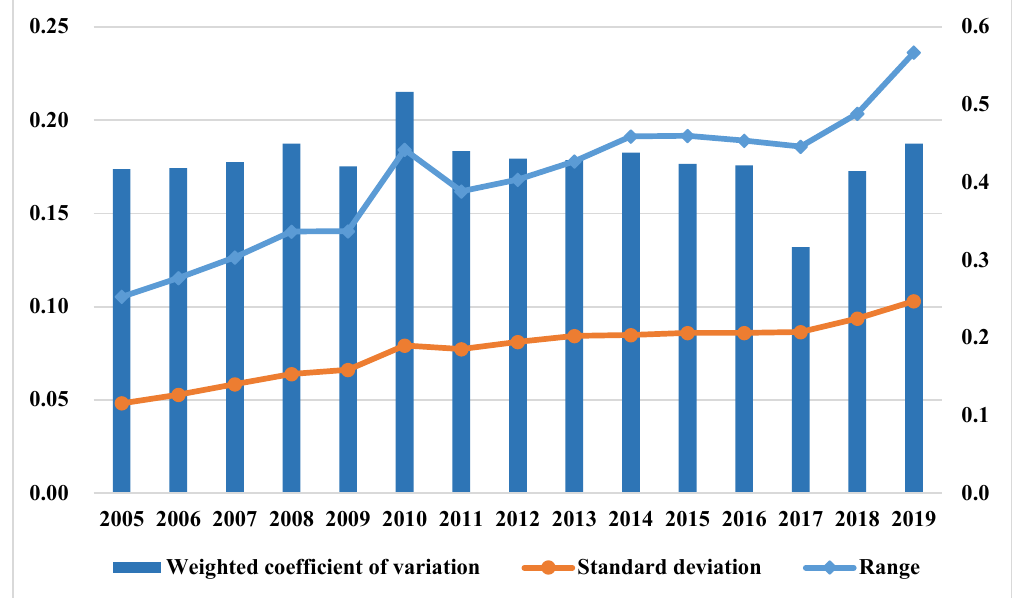
Figure 3. The absolute and relative differences of development level of open economy in the YRDA. From the point of view of evaluating the four subsystems of the development level of the open economy, the foundation of open economy in the YRDA shows a trend of steady growth, the scale of open economy shows a trend of rising and falling repeatedly.